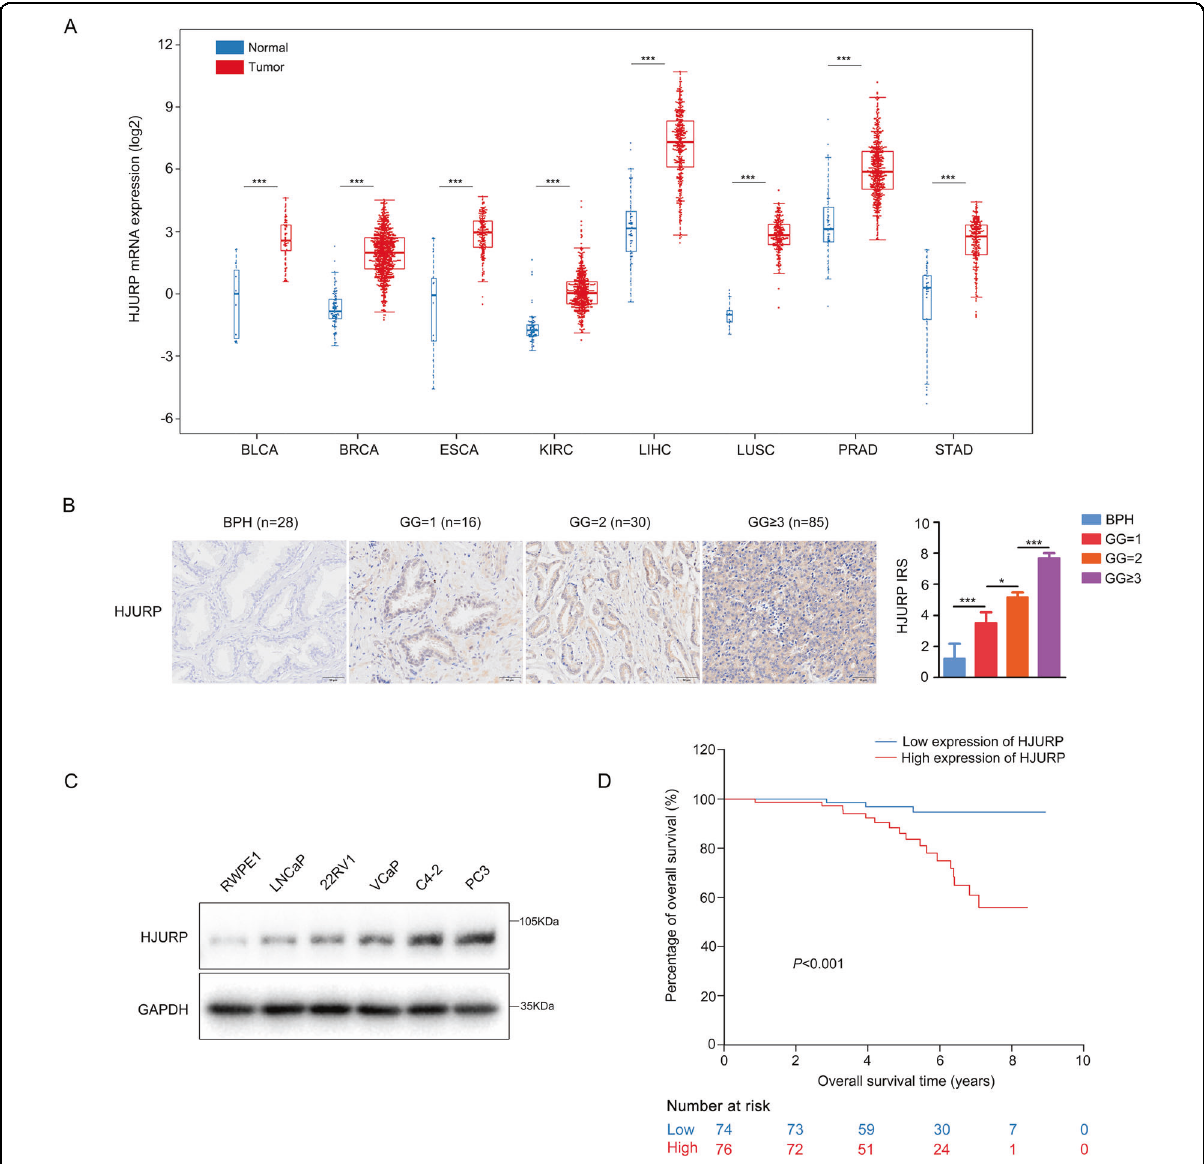
elevated in all eight types of tumors. B Representative IHC staining of HJURP in PCa and BPH tissues from our hospital (scale bar: 50 µm; magni fi cation: ×200). C Western blotting was used to measure HJURP expression in different PCa cell lines. D Kaplan – Meier plots demonstrating OS time strati fi ed